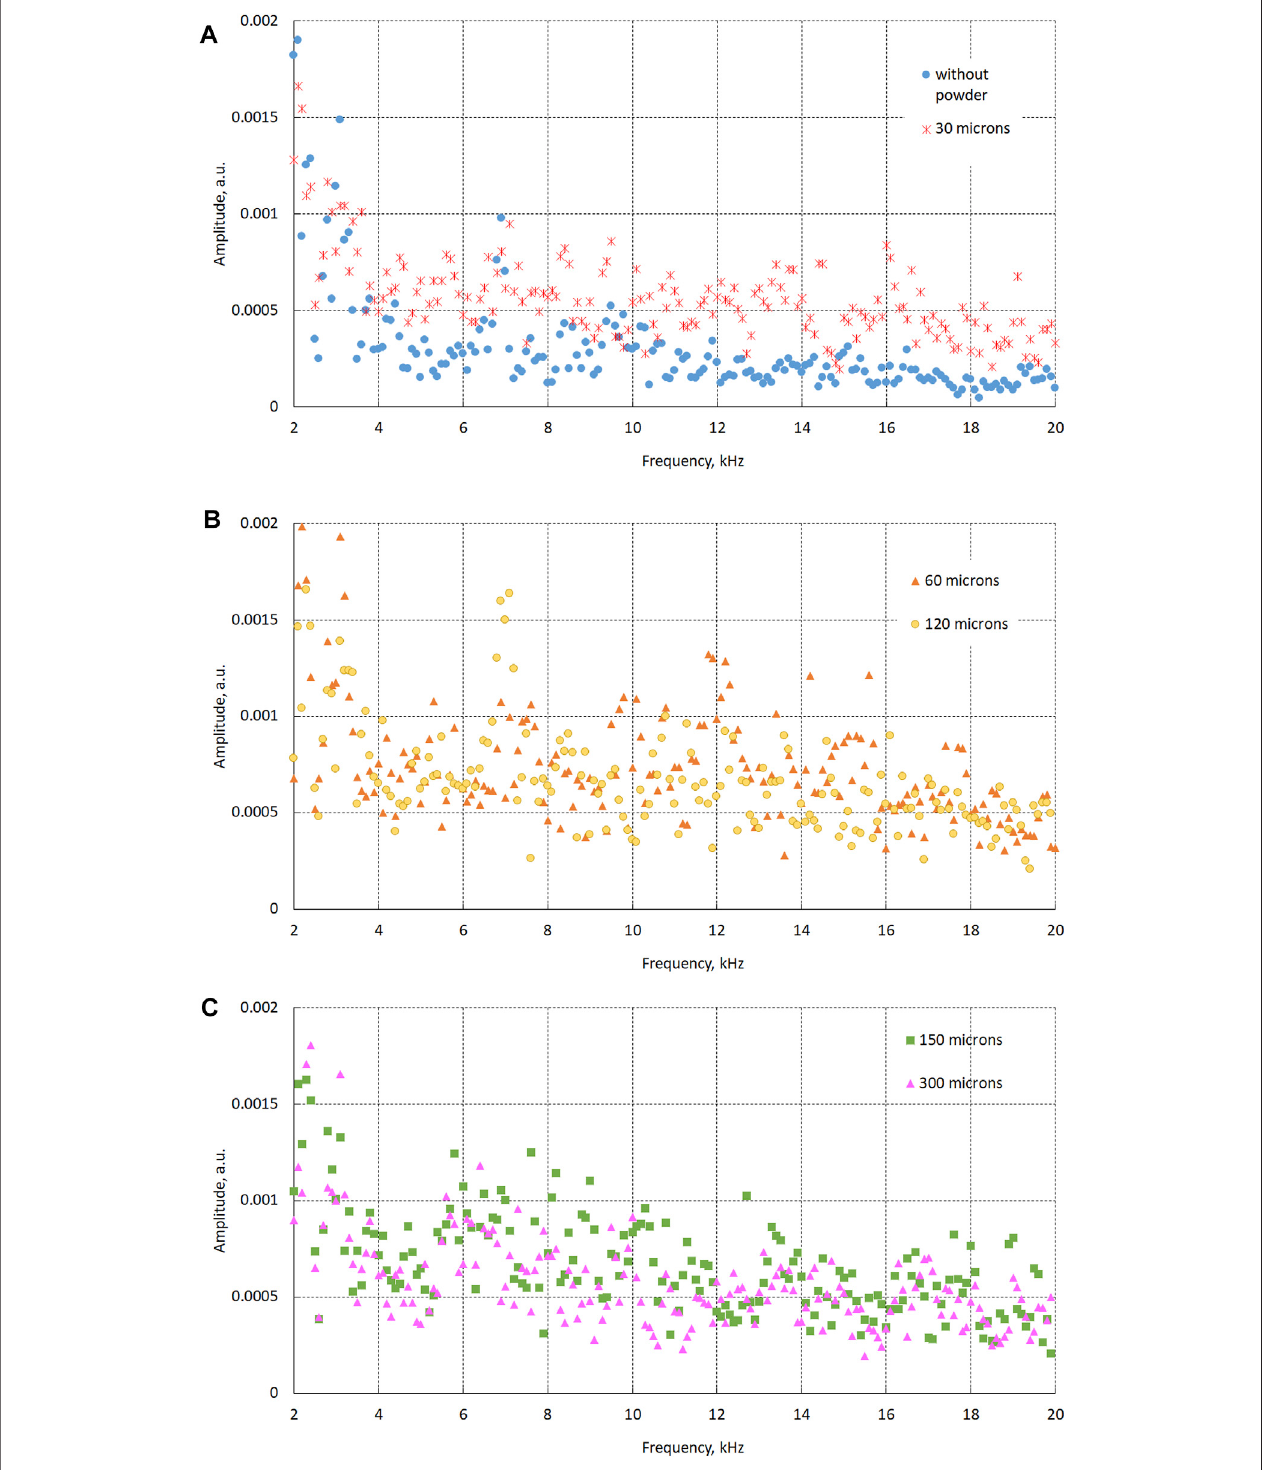
FIGURE 6 | Frequency spectrum and median intensity of Fast Fourier Transform (FFT) acoustic emission (AE) signals for single tracks produced without powder and 30 μ m (A) , 60 and 120 μ m (B) , 150 and 300 μ m (C) powder layer thickness.